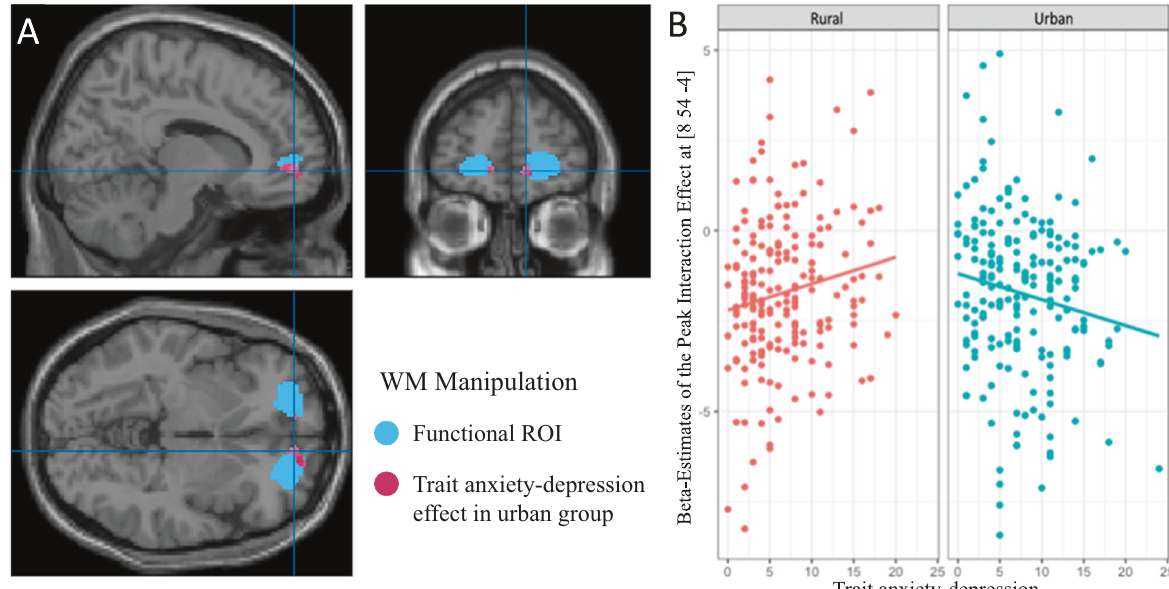
Fig. 3 Effects of childhood urbanicity on medial PFC function during working memory manipulation under social threat stress. A Brain map showing the mPFC functional ROIs sensitive to stress vs less-stress contrasts ( p < 0.05 voxel-wise FWE-corrected for multiple comparisons across the whole brain, blue), and peak correlation of mPFC suppression with increasing trait anxiety-depression during the WM manipulation task under social threat in individuals with urban childhoods ( N = 199, x = 18, y = 60, z = 6, T = 3.26; p < 0.001, p < 0.05 voxel-wise FWE corrected for multiple comparisons within the mPFC ROI). B Plot of the interaction between rural and urban childhoods, and trait anxiety- depression on stress-related mPFC engagement ( N = 394, x = 8, y = 54, z = − 4, T = 3.37; p < 0.001 uncorrected, p < 0.05 voxel-wise FWE corrected for multiple comparisons within the mPFC ROI). In the group with more urban childhoods, increased trait anxiety-depression was associated with in a larger reduction in mPFC engagement during stress. In subjects with rural childhoods, however, this effect was less